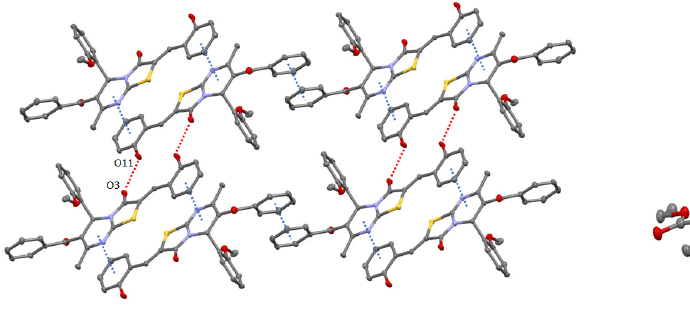
Figure 4. ORTEP view of crystal packing of 11 ( a ) and 12 ( b ) showing 2D layer and 1D chain for ‐ mation resulting from both the intermolecular H ‐ bonding and/or π – π /CH– π interactions (red and blue dotted lines, respectively). The ellipsoids are presented with 50% probability, H ‐ atoms are omitted for clarity.